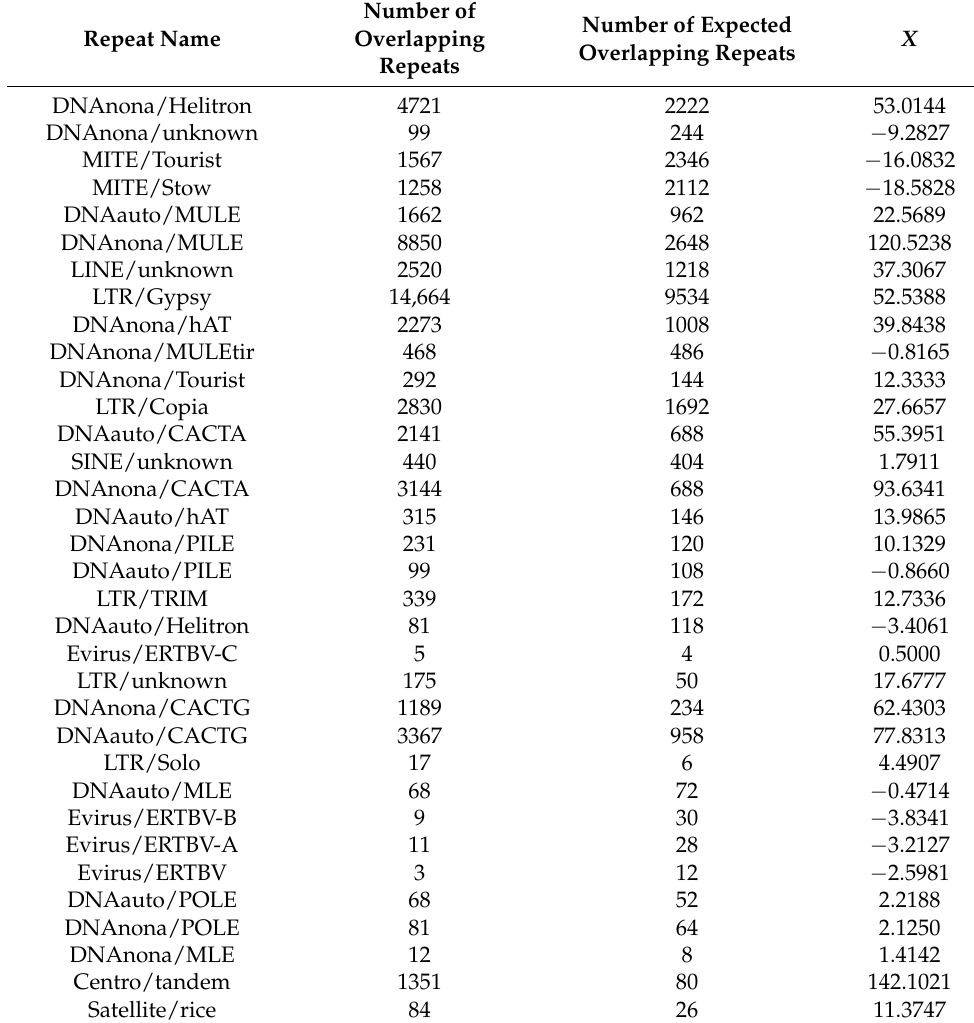
Table 5. Intersection of regions with periodicity and known transposons and repeats. X is the normal distribution argument of the identified intersections calculated using the Monte Carlo